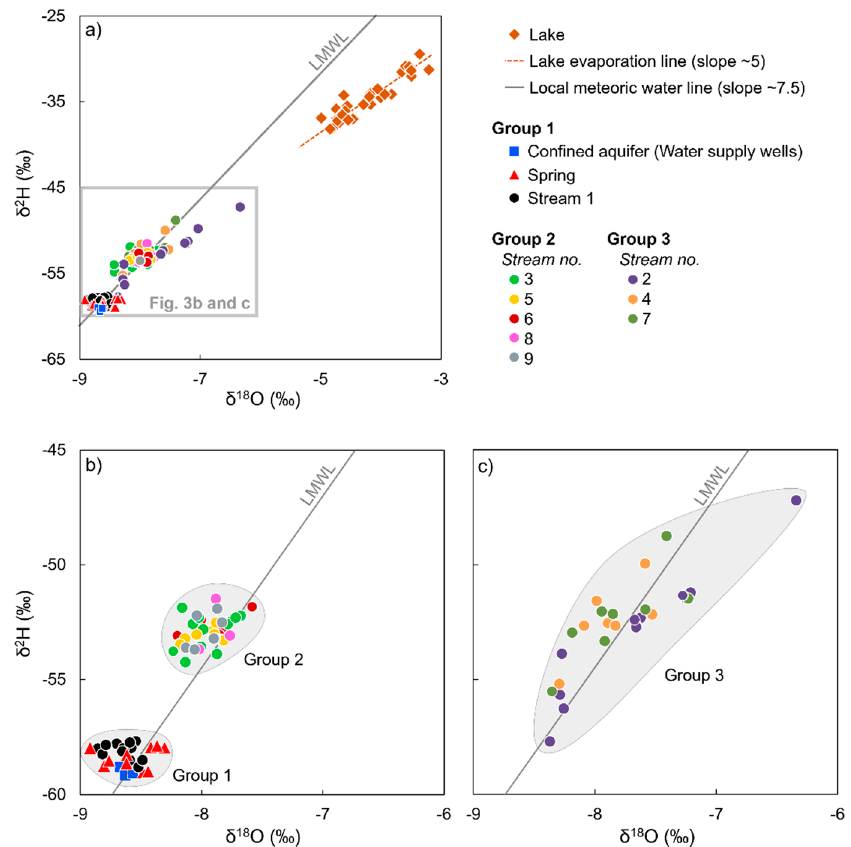
Figure 3. δ 18 O and δ 2 H values for ( a ) all streams, the spring, the water supply wells and the lake. Panels ( b ) and ( c ) are subsets of panel ( a ); note the different range of the y - and x -axes. Group 1 and 2 in ( b ) represent clustered isotope data, while group 3 in ( c ) represents fluctuating isotope data. Local meteoric water line (LMWL) is from [44].